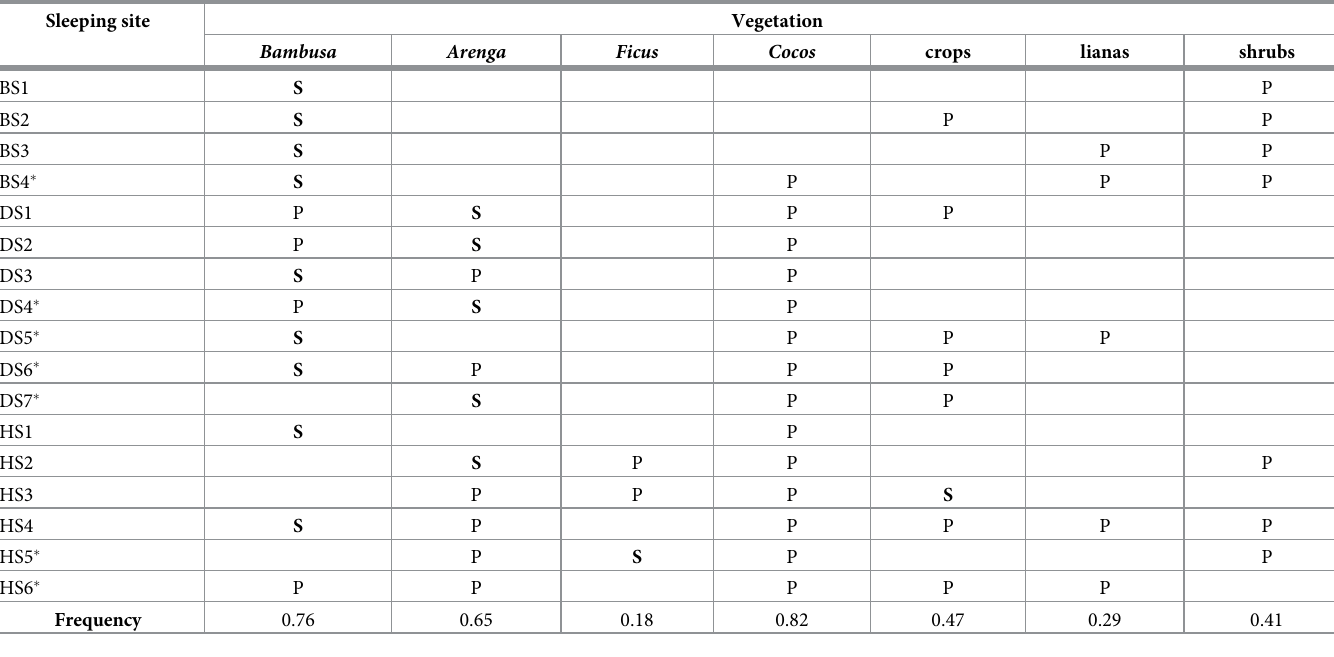
Table 2. Vegetation around tarsier sleeping sites on Bunaken, Manadotua, and Mantehage islands. Sleeping